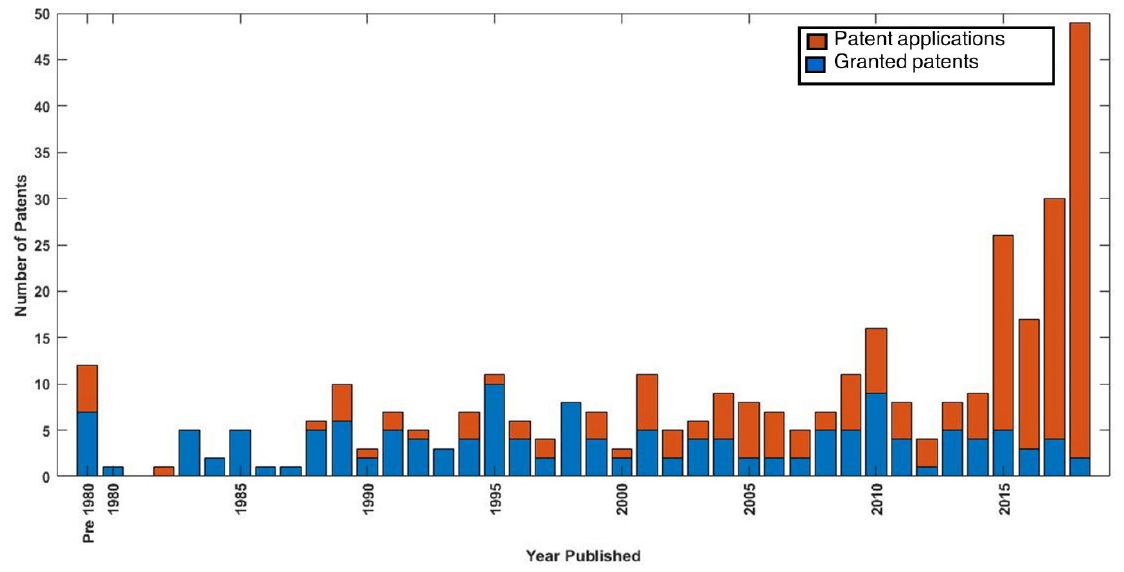
Figure 2. Number of patent documents according to their publication year.